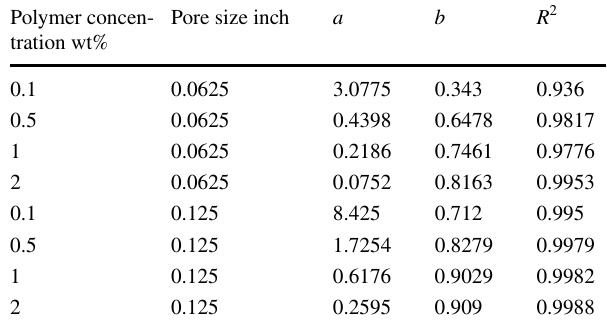
Table 2 “ a ” and “ b ” parameters values for all